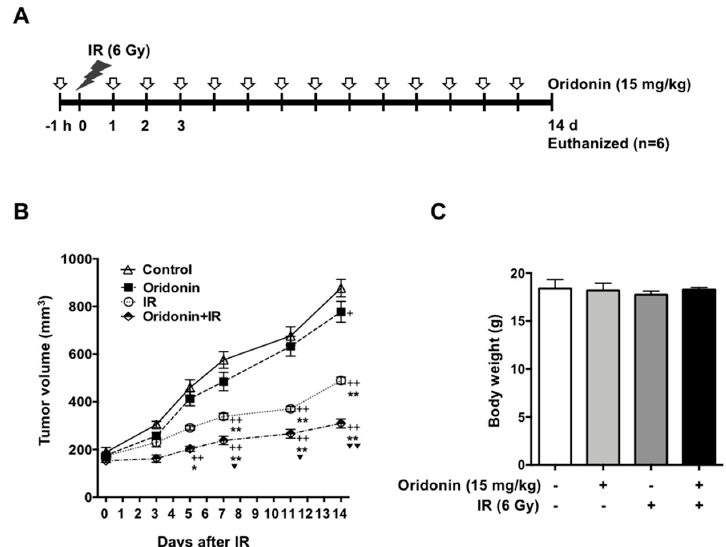
Figure 6. Effect of oridonin on radiotherapy. ( A ) Schema of the timeline for oridonin and irradiation treatment. Daily oridonin (15 mg/kg, intraperitoneal injection) was administered up to the indicated time points pre- and post-irradiation (6 Gy); ( B ) growth curves of H460 tumors following oridonin and/or IR treatment. ( C ) Mean body weights of experimental groups at study termination. The data represent the means ± SEM of six mice per group. + p < 0.05 and ++ p < 0.01 compared to control; * p < 0.05 and ** p < 0.01 compared to oridonin; ▼ p < 0.05 and ▼▼ p < 0.01 compared to IR.